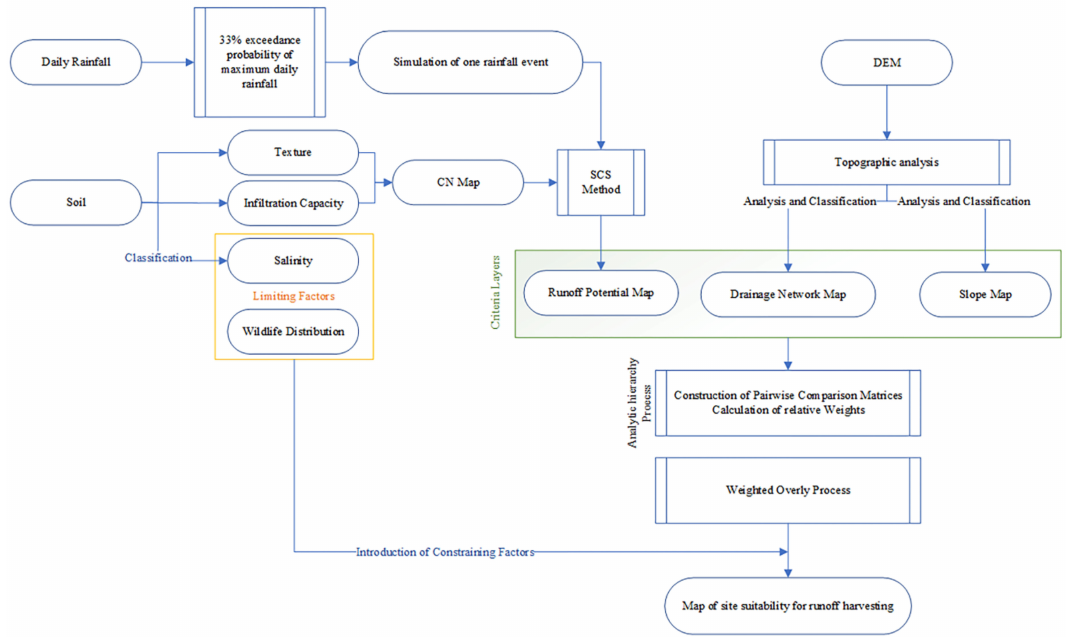
Figure 3. Flowchart illustrating the breakdown of the steps taken for identifying suitable areas for runo ff harvesting in Kavir National